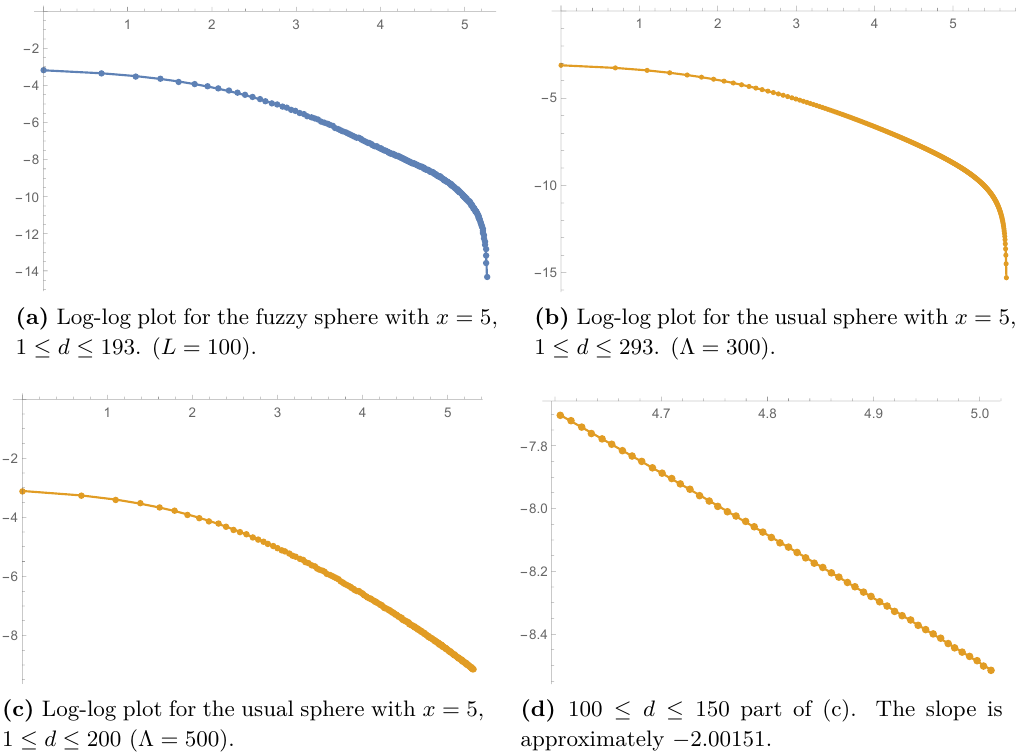
(c) Log-log plot for the usual sphere with x = 5 , 1 ≤ d ≤ 200 ( Λ = 500 ). Figure 10 . Log-log plot of the mutual information I ( x, d ; Λ) between H ( x ) the cutoffs are 2 L = 100 and Λ = 300 or 500 . The vertical axis is log I (5 , d ; Λ) (without − λ 2 ln λ 2 factor) and the horizontal axis is log d . The figure (d) is the zoom-up of a part of the figure (c), 100 ≤ d ≤ 150 . The other parameters are R = 1 and µ = 5